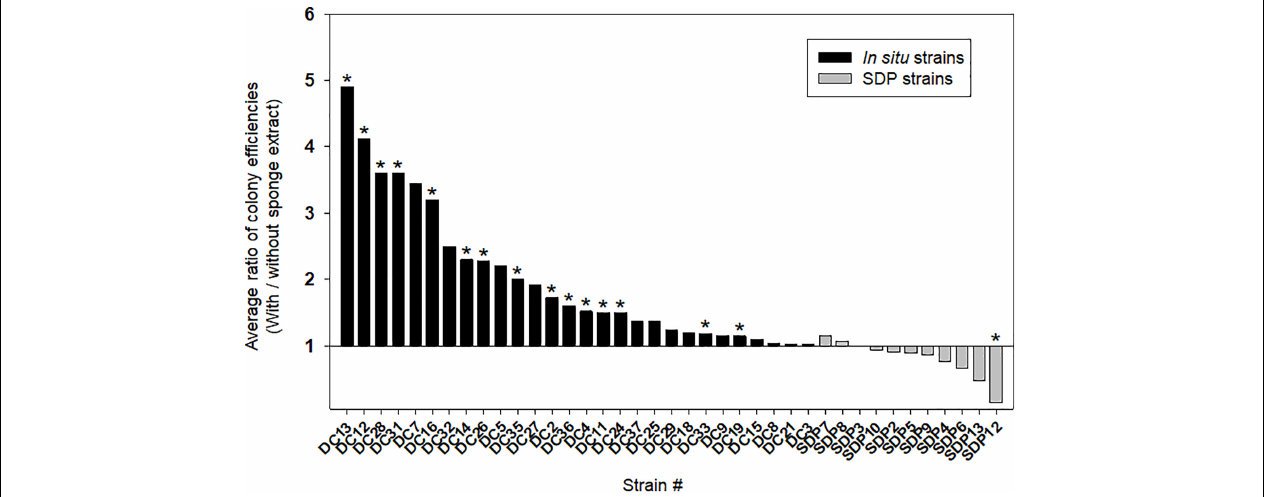
FIGURE 4 | Effect of the sponge extract on starvation recovery of the in situ and SDP strains. The ratio of colony efficiencies between the value measured under two culture conditions (colony numbers on the agar medium with the sponge extract/colony numbers on the agar medium without the sponge extract) was calculated for each selected strain. The ratio was calculated with average value from triplicate measurements ( n = 3) of the CFUs on each agar plate. The asterisks indicate that the value of bar graph is a significantly different between two conditions by statical analysis ( t -test; p < 0.01).